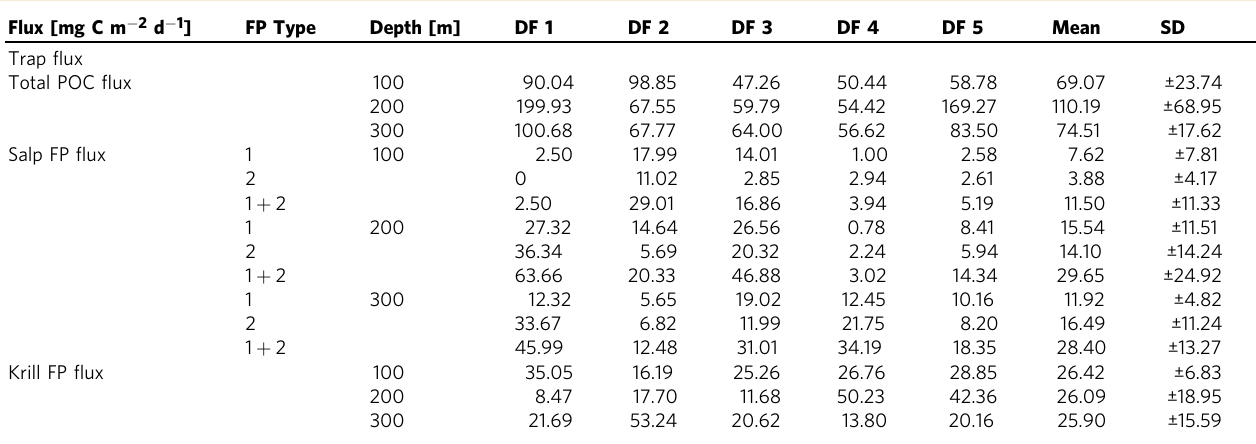
Table 4 Carbon fl ux measured from the drifting sediment traps.